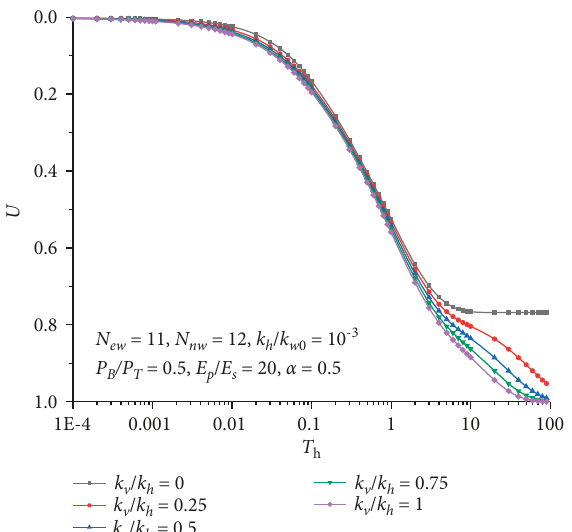
v on average consolidation degree when